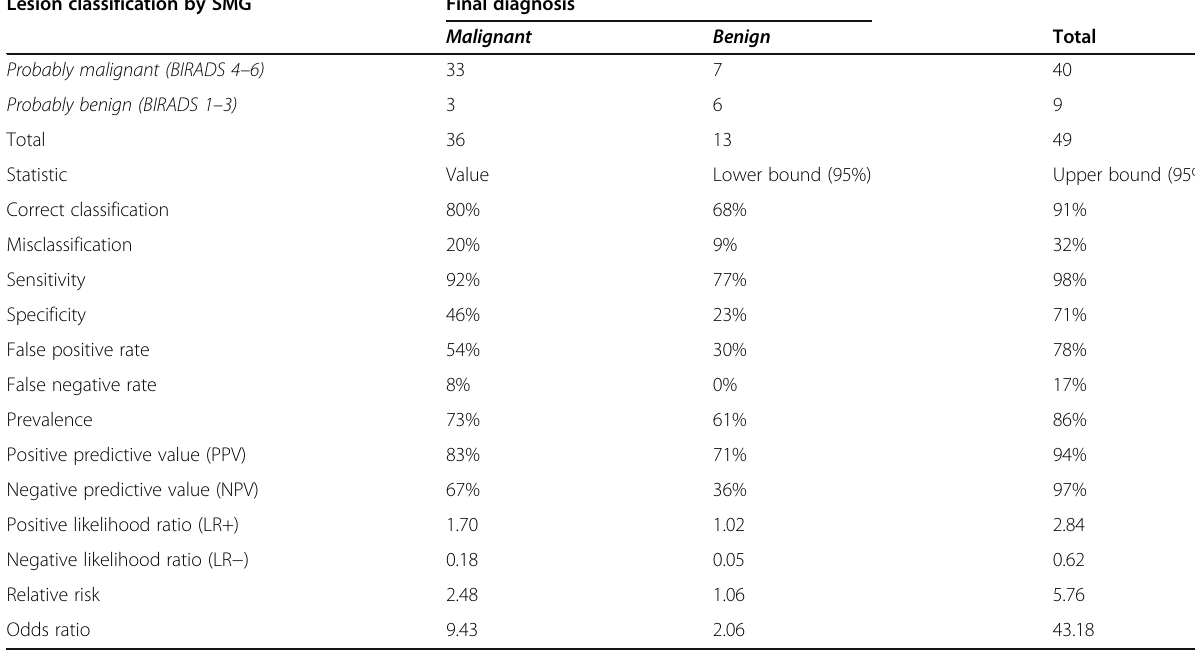
Table 5 Diagnostic accuracy of SMG in tested patients with ACR grade A/B versus the result of biopsy or follow-up as the gold standard for lesion